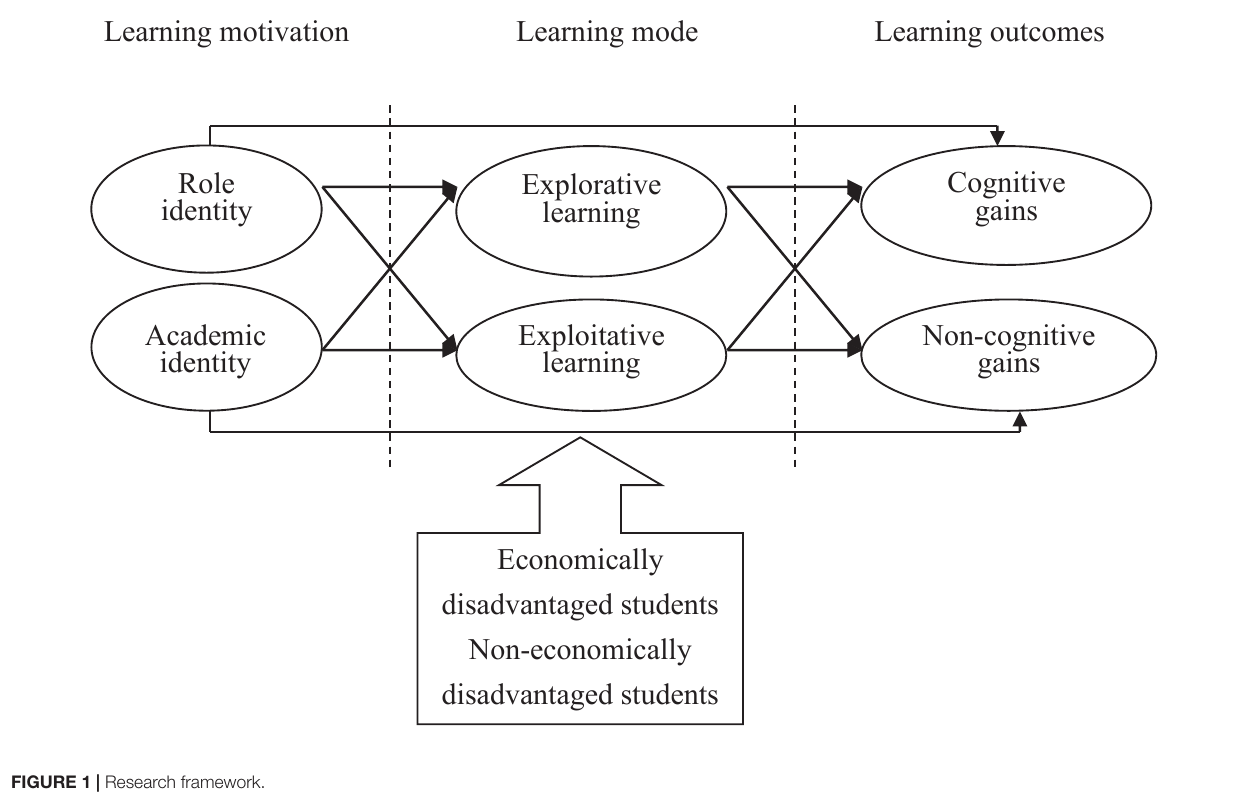
FIGURE 1 | Research framework.